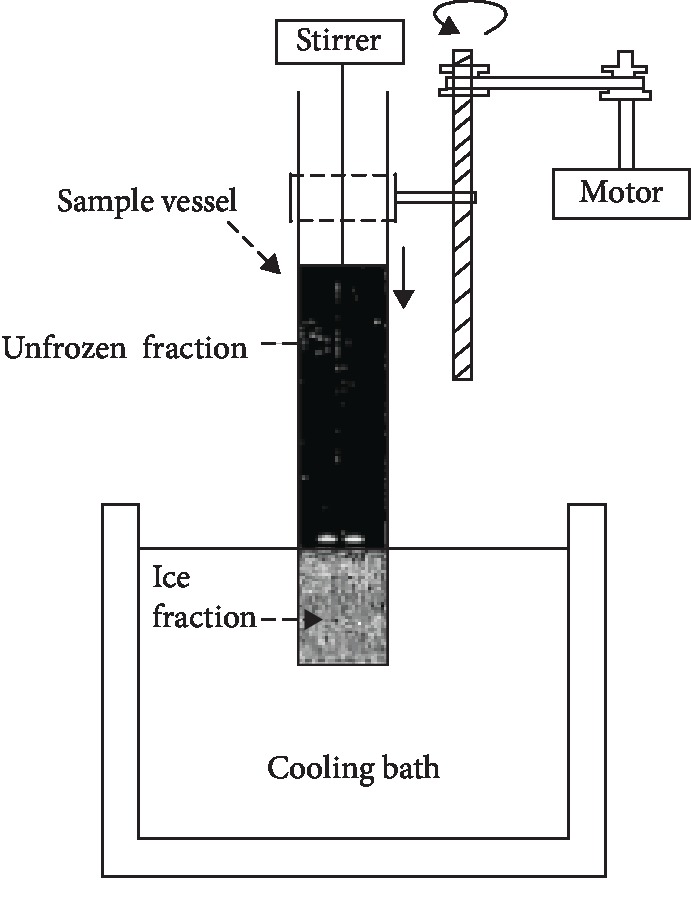
The sketch diagram for the PFC setup; source: [6, 18].